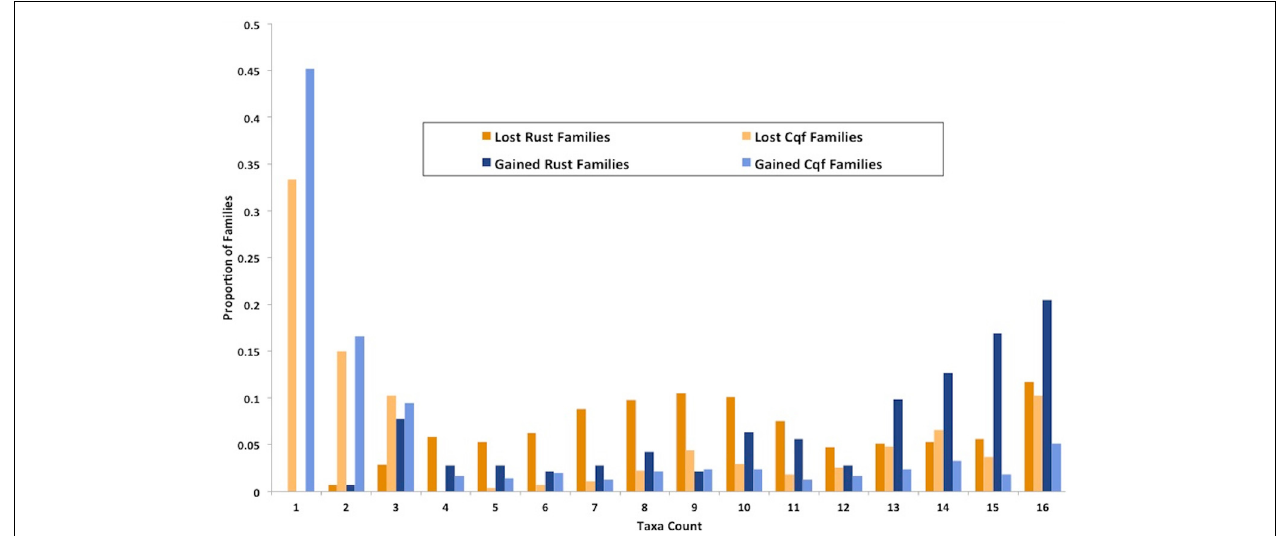
FIGURE 6 | Families gained and lost in rust pathogens and Cqf have varying levels of taxonomic conservation. The proportion of gene families (y-axis) that contain protein members from 1 to 16 fungal taxa (x-axis) among those that have either expanded or contracted in the rust fungi or Cqf .